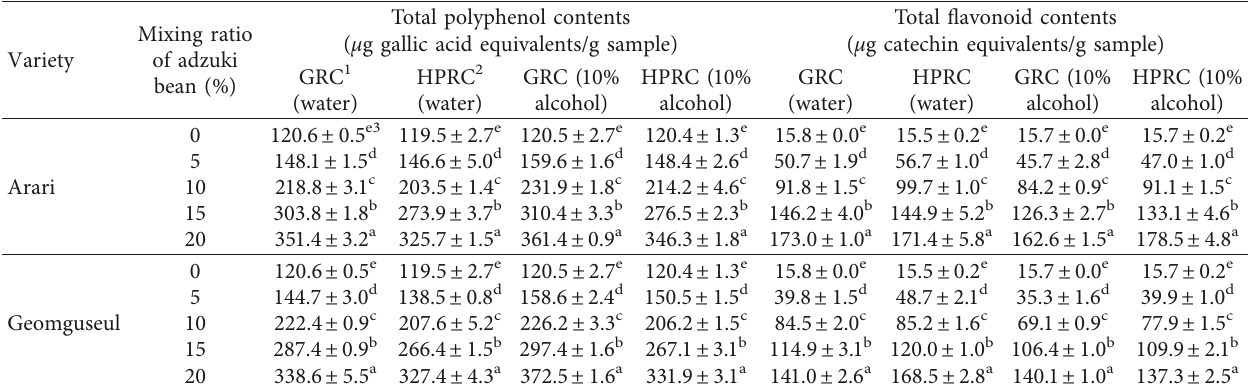
Table 3: Total polyphenol and flavonoid contents of the ethanolic extracts with different mixing ratio of adzuki bean ( Vigna angularis var. nipponensis cv. Arari and cv. Geomguseul) and cooking methods.